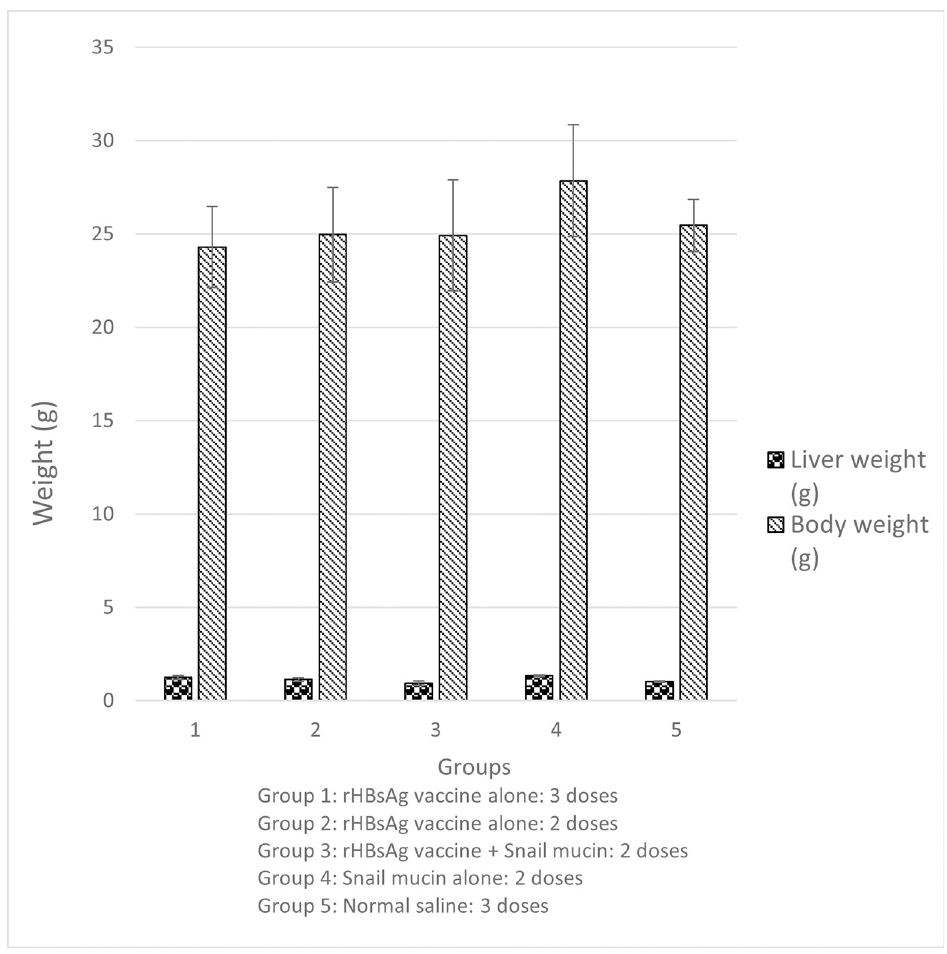
Fig 1. Effect of snail mucin-adjuvanted rHBsAg vaccine on the body and liver weight of experimental mice. Results are expressed as mean ± SD (n = 5) with a confidence interval of 0.05.